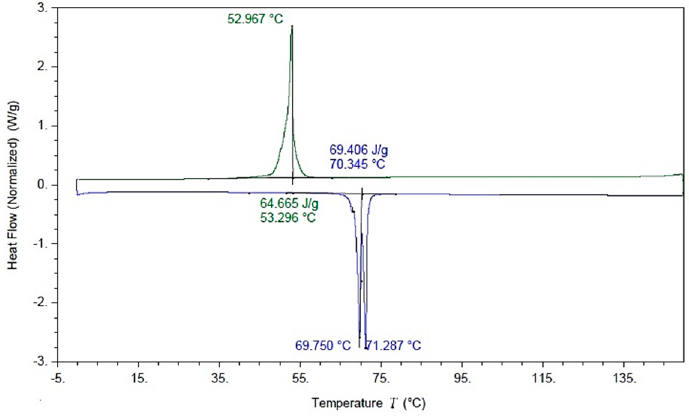
Figure 2. Differential scanning calorimetry (DSC) of 1 , second heating (green) and cooling (blue) cycle.